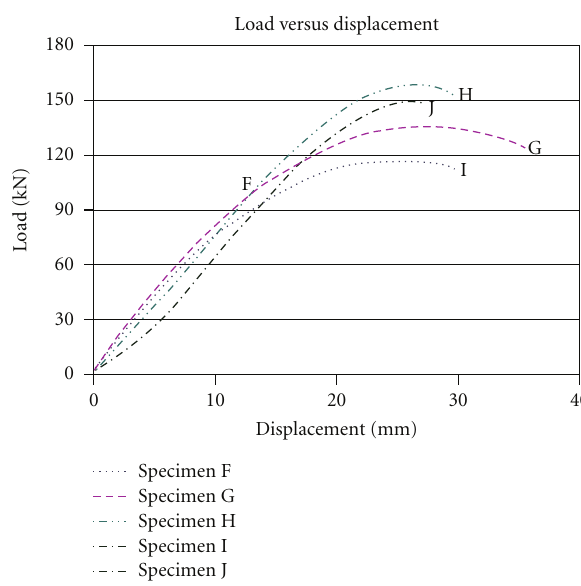
Figure 4: Comparison of results: boracol treated.